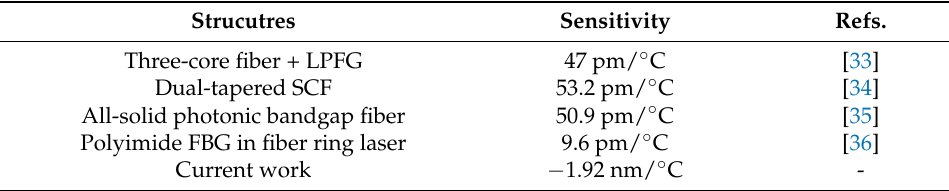
Table 1. Comparison with other FRL sensing